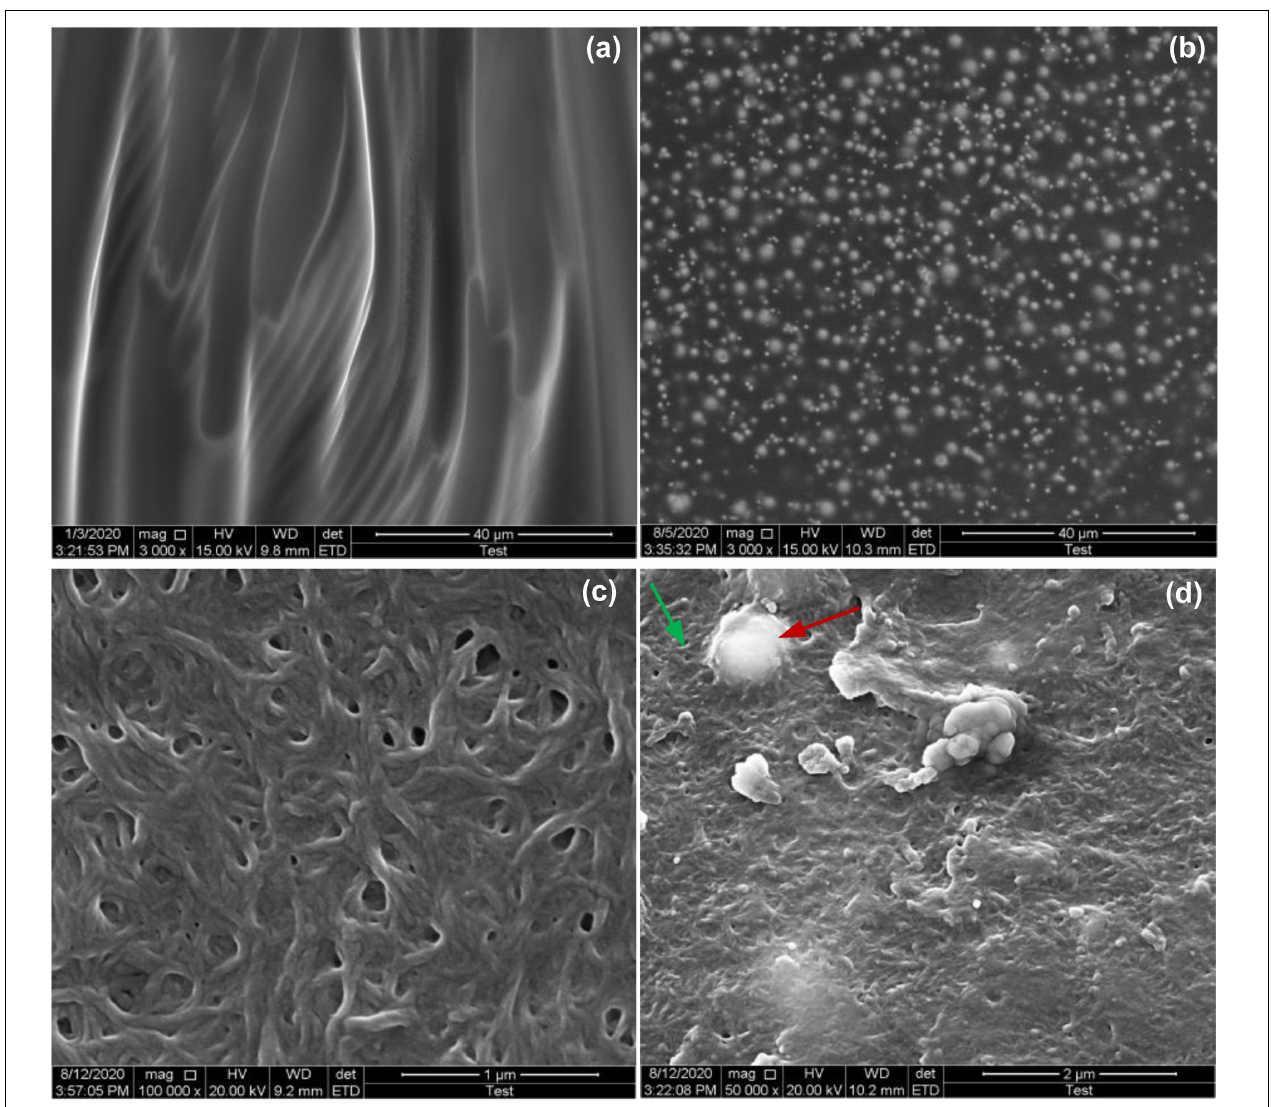
FIGURE 1 | SEM images of (a) grease matrix and (b) MRG-70 without magnetic field. (c) and (d) microstructures of the grease and MRG-70 with the extracted base oil, respectively. The red arrow shows the CIP, and the green arrow shows the entangled fibrous